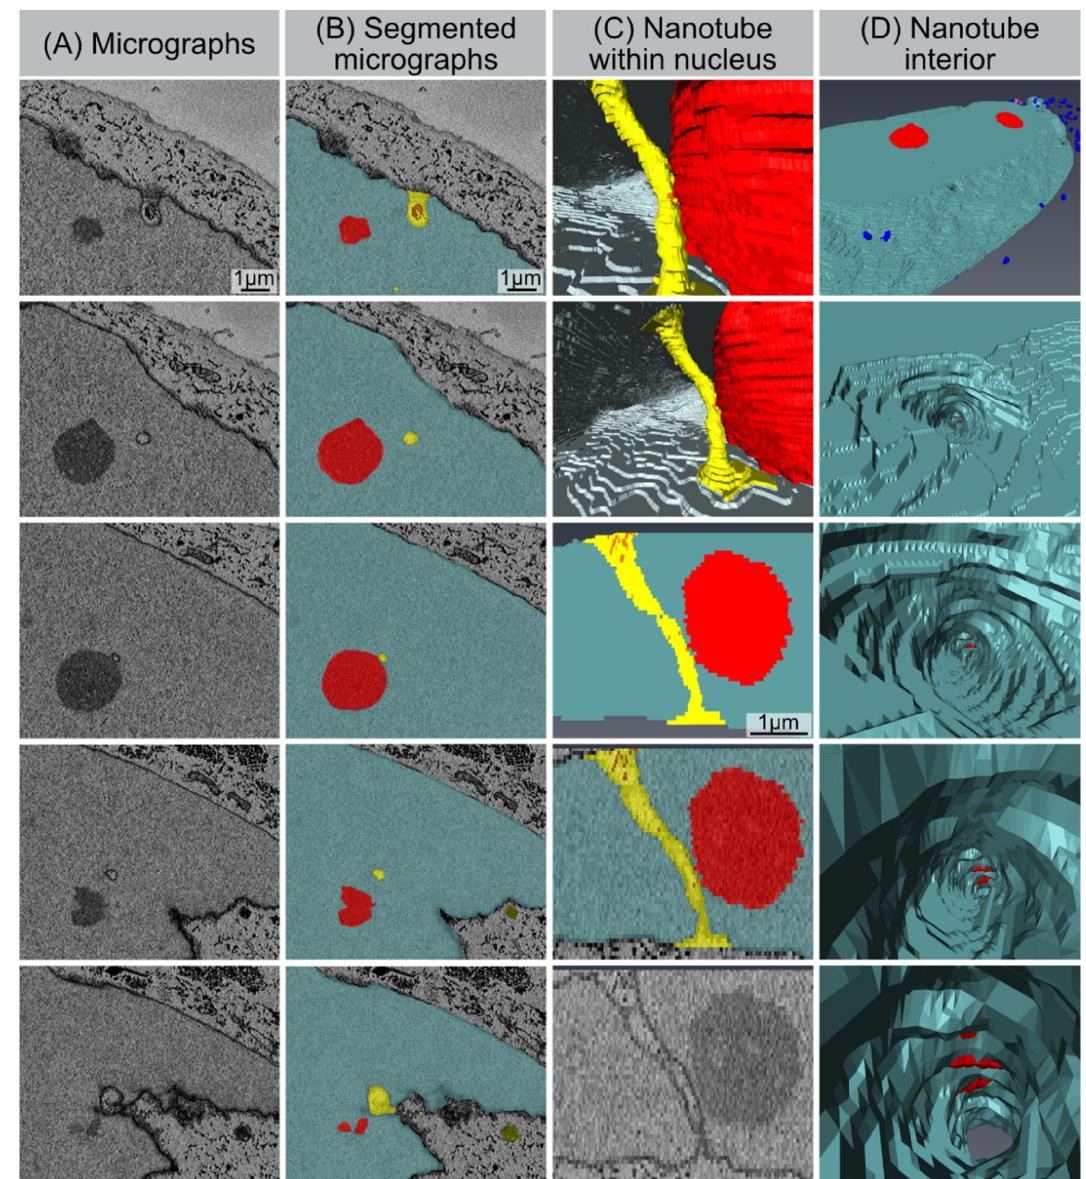
Figure 6. Nucleo ‐ cytoplasmic nanotube. ( A ) Original micrographs showing cross ‐ sections of the nanotube. ( B ) Segmented micrographs for the same area: nucleus (light ‐ blue), nucleoli (red), nanotubes (yellow). ( C ) Models showing nanotube’s appearance from within the nucleus (1st and 2nd image from top), segmented volume showing the nanotube from side (3rd and 4th image from top), and original micrograph of the same region. ( D ) Visualization of the nanotube’s interior.